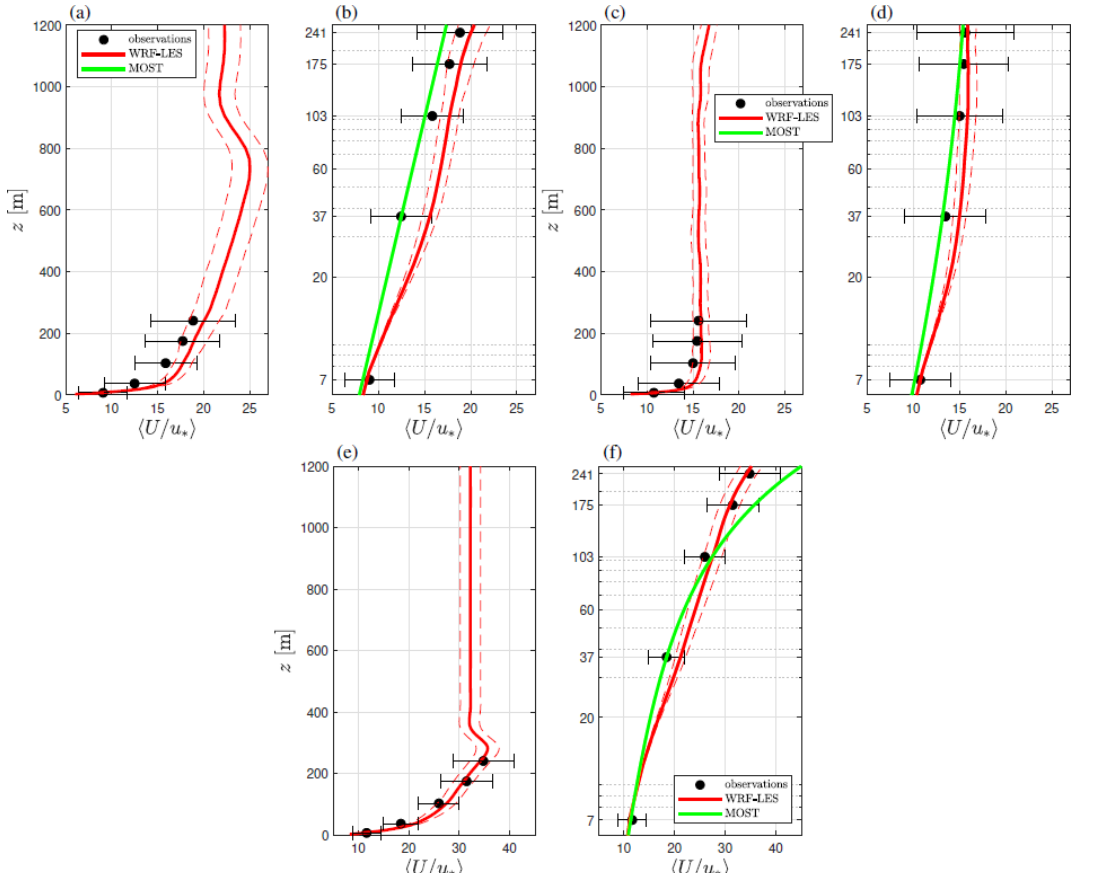
Figure 7. Normalized simulated and observed wind profiles for neutral (a, b) , unstable (c, d) , and stable (e, f) conditions. MOST profiles (Eq. 1) are also shown. The error bars and dashed lines denote ± 1 standard deviation from the mean of the observations and simulations,